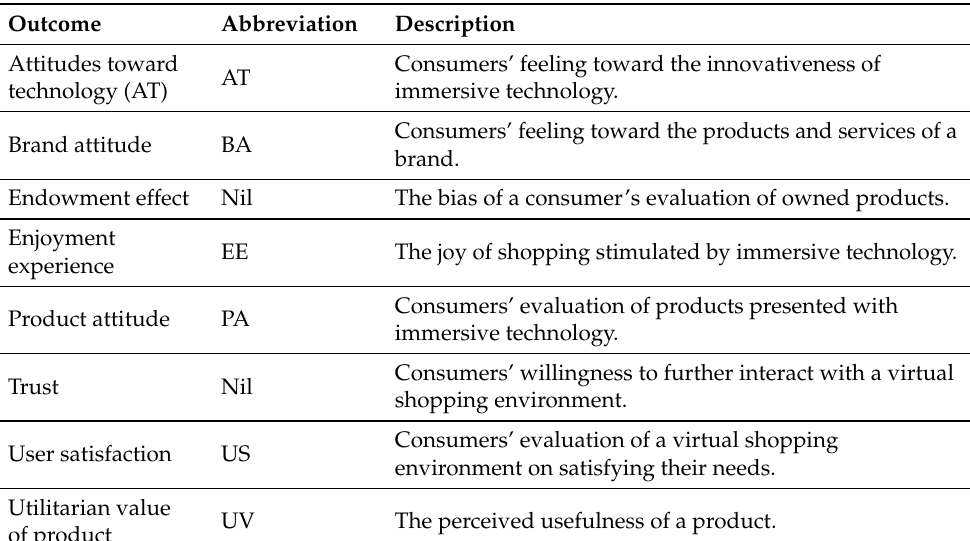
Table 6. Final outcomes to purchase